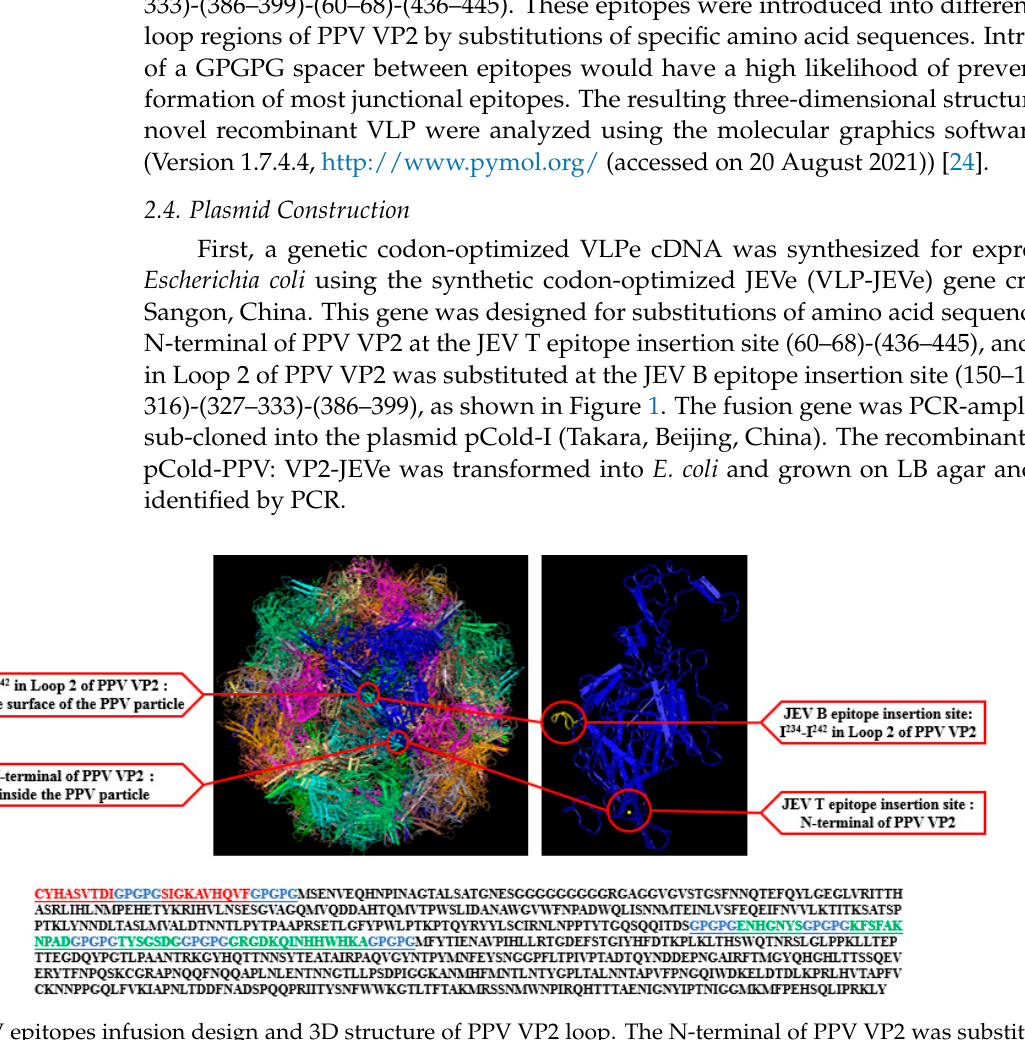
Figure 1. JEV epitopes infusion design and 3D structure of PPV VP2 loop. The N-terminal of PPV VP2 was substituted by the JEV T-epitopes insertion sites (60–68)-(436–445) (red in color), while I 234 -I 242 in Loop 2 of PPV VP2 was substituted by JEV B epitope insertion sites (150–156)-(307–316)-(327–333)-(386–399) (green in color). GPGPG were used as a spacer between epitopes (blue in color). Porcine Parvovirus Capsid PBD: